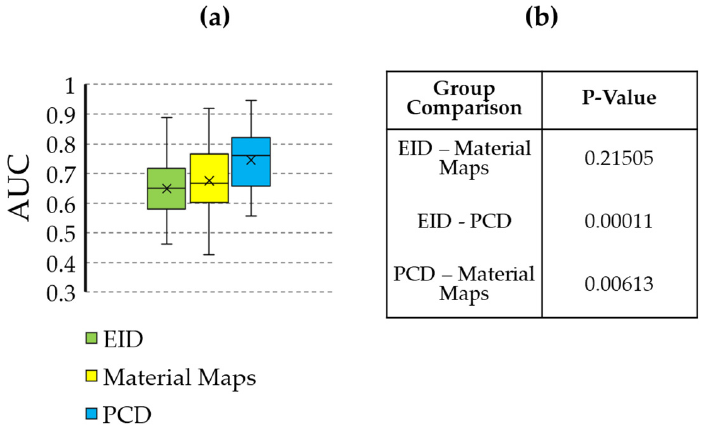
Figure 7. Statistical comparison of the AUC values resulting from classification training using the different feature sources (EID, PCD, material maps). ( a ) Box and whisker plot showing the AUC values. ( b ) Table containing the p -values comparing each grouping. The AUC of the PCD classifier is significantly higher than that of the EID and material maps.